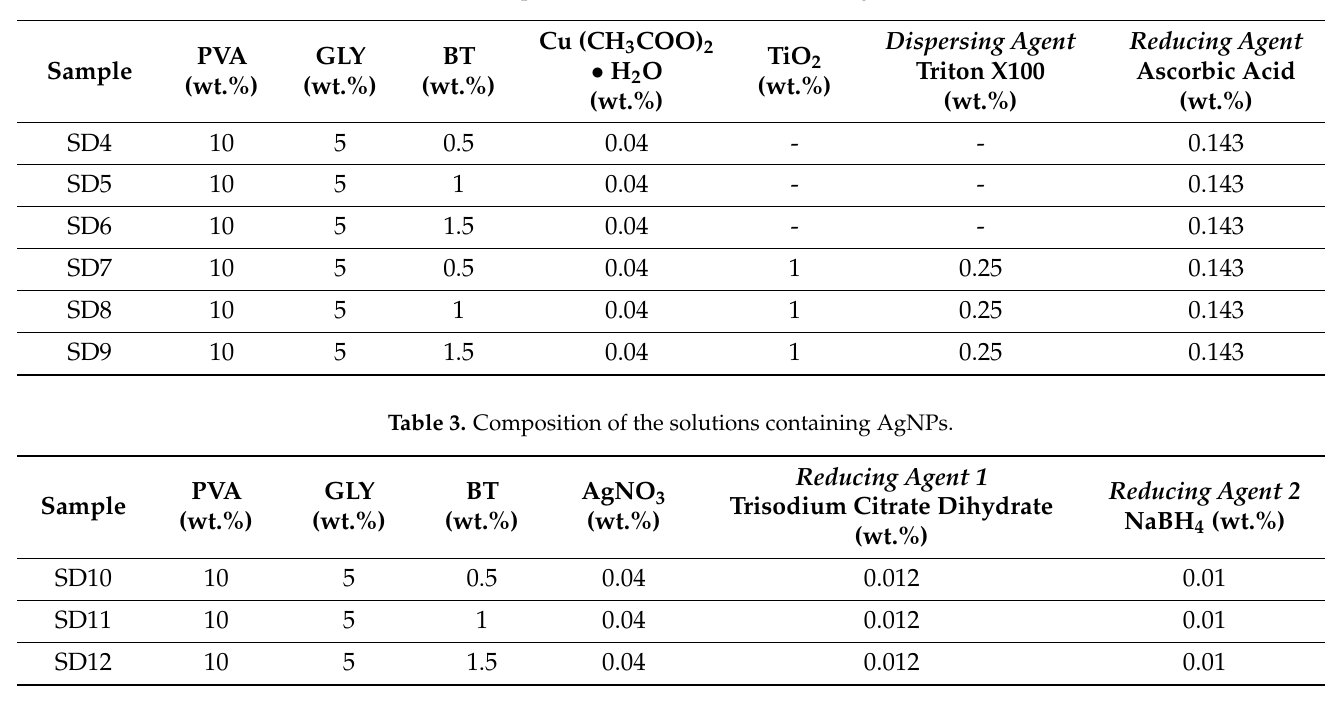
Table 2. Composition of the solutions containing CuNPs.